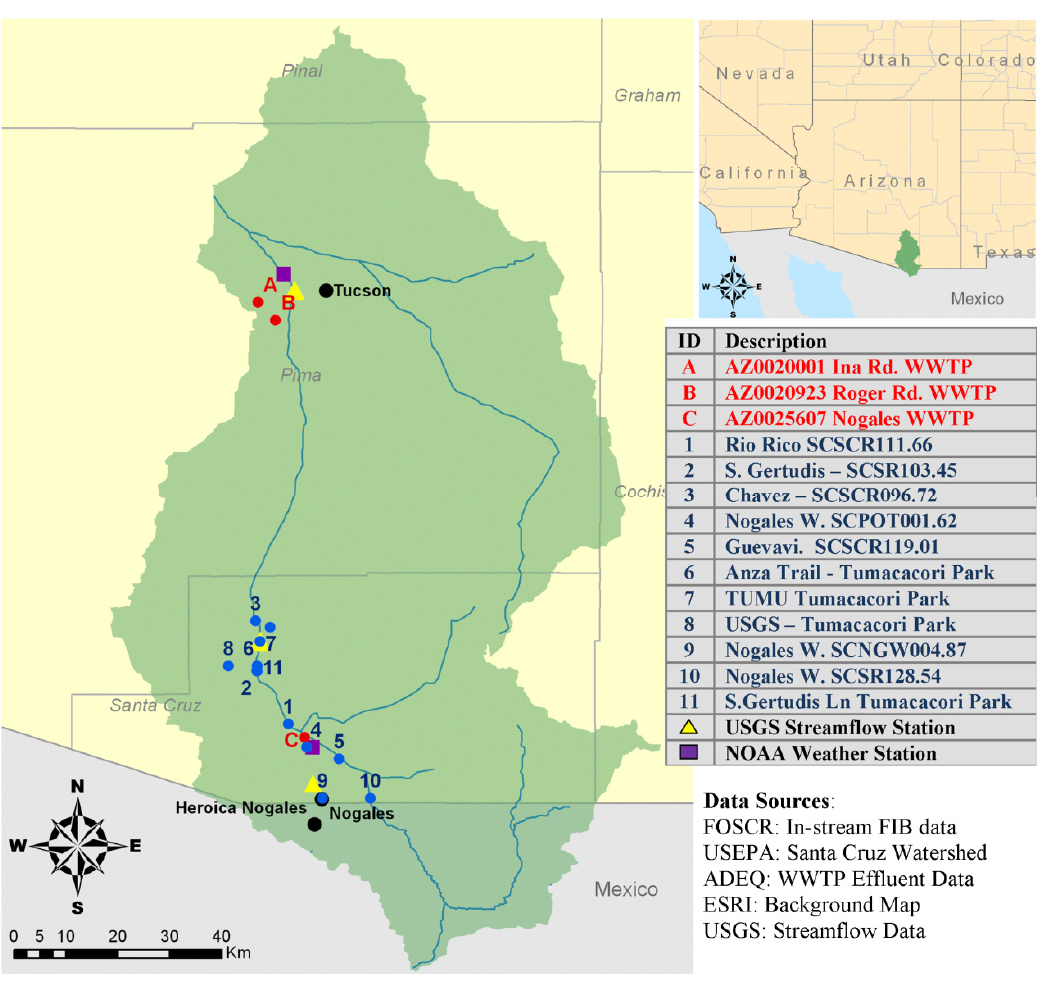
Figure 1. The Santa Cruz Watershed, fecal coliform and E. coli sampling locations, weather stations, and United States Geological Survey (USGS) streamflow stations